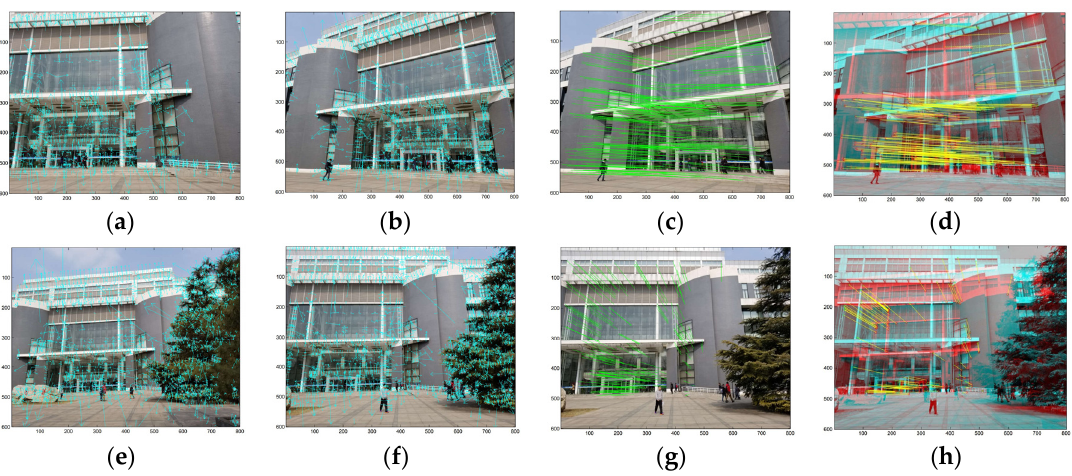
Figure 6. Matching of scale ‐ invariant feature transform (SIFT) descriptor. ( a , b ) Two adjacent images with SIFT features corresponding to a rotation of the camera; ( c ) displacement of the key points from ( a ) to ( b ); ( d ) inliers to compute the essential matrix; ( e , f ) two adjacent images with SIFT features corresponding to a forward movement of the camera; ( g ) displacement of the key points from ( e ) to ( f ); ( h ) inliers to compute the essential matrix. By observing the position change of the key points from one frame to the next, key points move in a radial direction when the camera moves forward and move in parallel when the camera rotates.